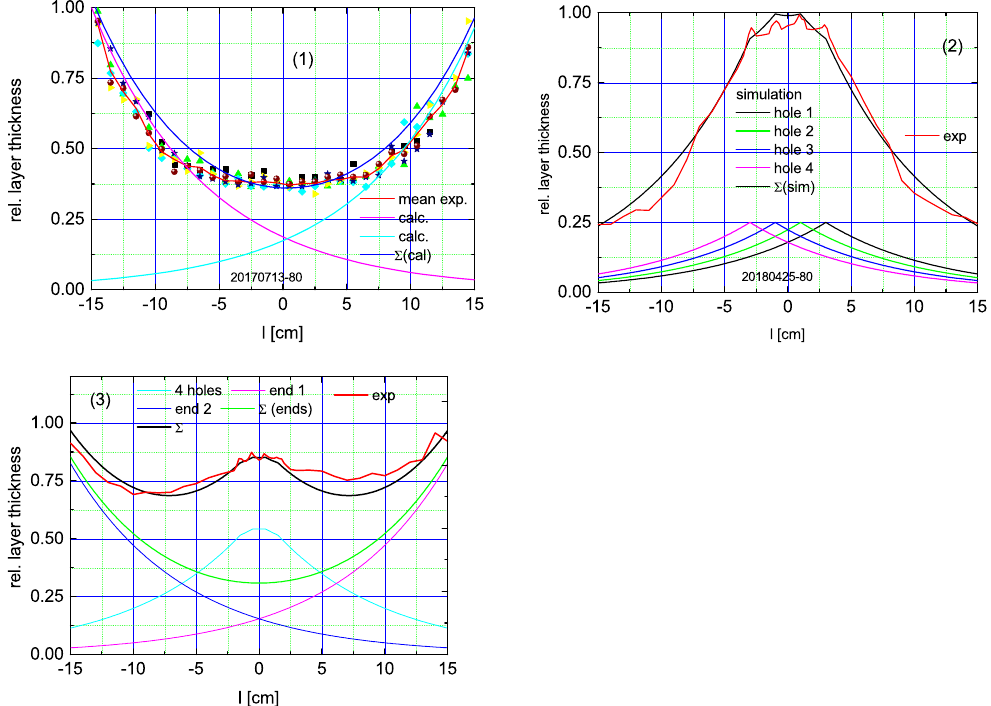
Figure 9. Relative thickness of the PPX layer as function of length. ( 1 ) Both ends open, ( 2 ) both ends closed, 4 drainage openings separated by 2 cm in the middle, ( 3 ) both ends open and 4 drainage openings. The lower vapor density at the lower entrance ( − 7.2% is taken into account for simulations 1 and 3. In 3, the central holes are only 1 cm